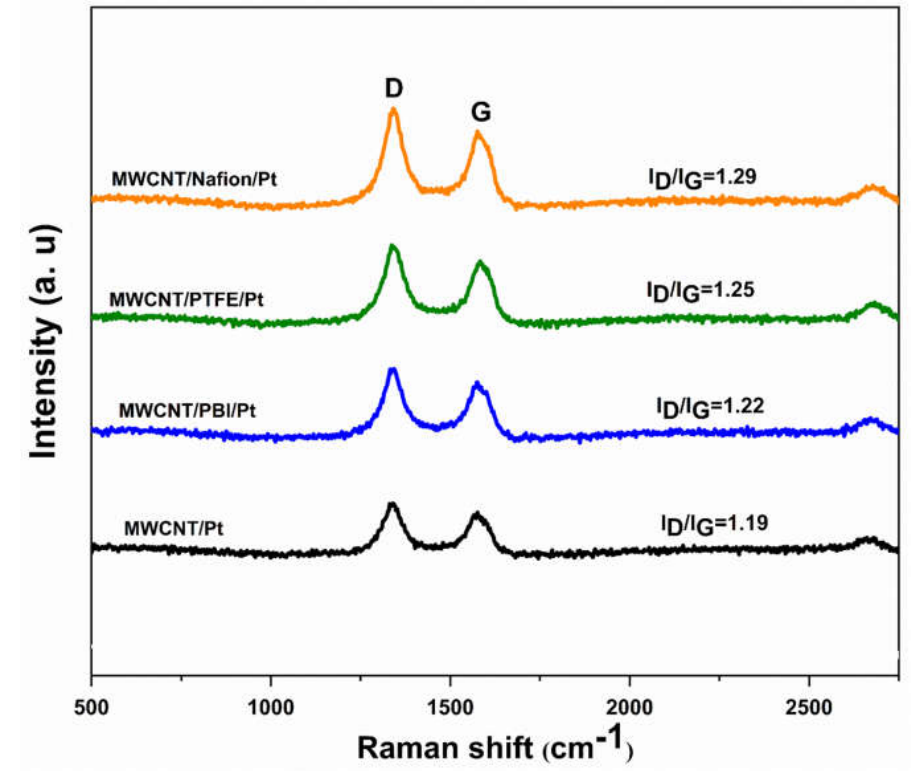
Figure 4. Raman spectroscopy analysis of various